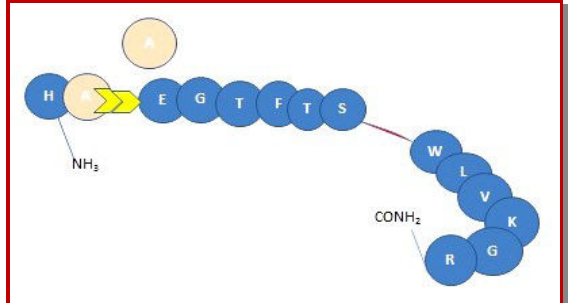
Figure 1: Cleavage site of GLP-1 protein by DPP4 (The yellow colour marking indicates DPP4 interrupting point of GLP-1)